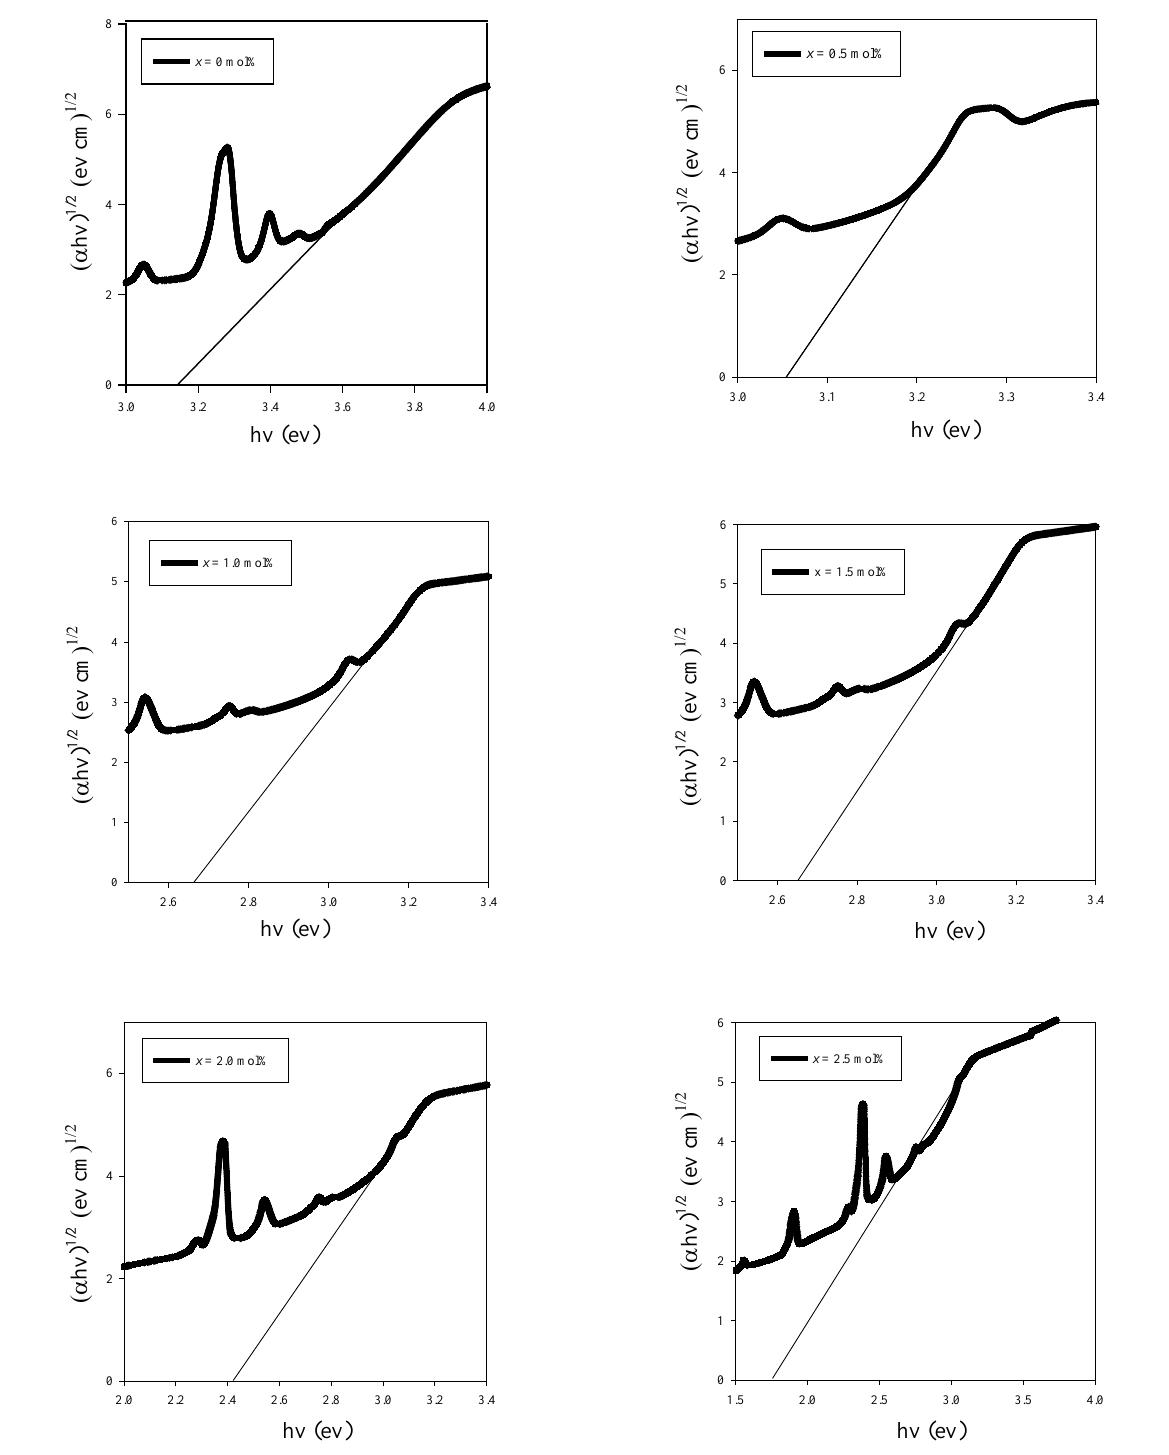
Figure 6. Straight line of curve at x -axis when ( α hv ) 1/2 = 0. All the graph represents the typical extrapolation of Tauc’s plot of the glass samples.